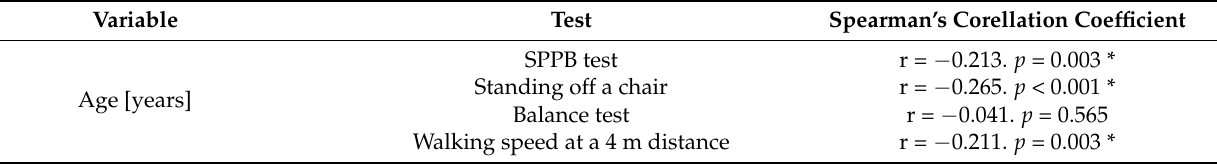
Table 5. Correlations between the SPPB test results and age, number of chronic diseases and